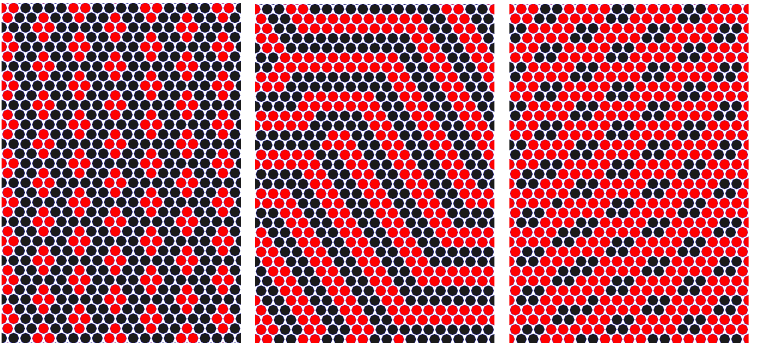
= 10.0. ( Left , central, 2 = 0.0, µ ∗ = 10.0, and µ ∗ = 20.0, respectively. Red and black 1 1 1